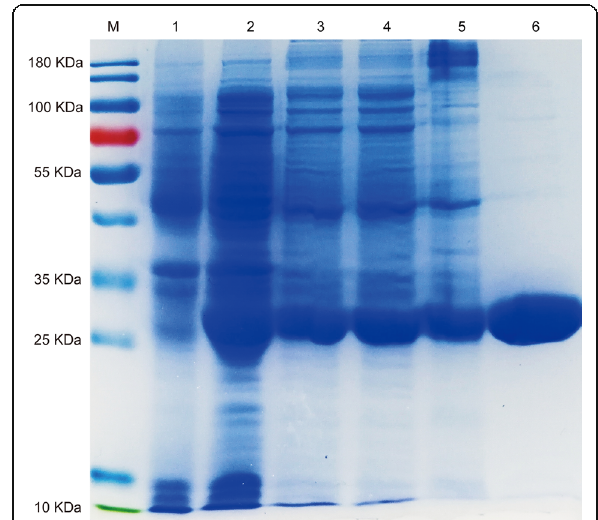
Fig. 2 Analysis of QseB protein. Lane 1, cell lysate of BL21 (DE3) containing plasmid pET-30a; Lane 2, lysate of BL21 (DE3) containing plasmid pET- qseB without isopropyl- β -D-thiogalactoside (IPTG) induction; Lane 3, cell lysate of BL21 (DE3) containing plasmid pET- qseB with IPTG induction at 25 °C for 4 h; Lane 4 and 5, supernatant (lane 4) and inclusion body (lane 5) of cell lysate of BL21 (DE3) containing plasmid pET- qseB with IPTG induction at 25 °C for 4 h;